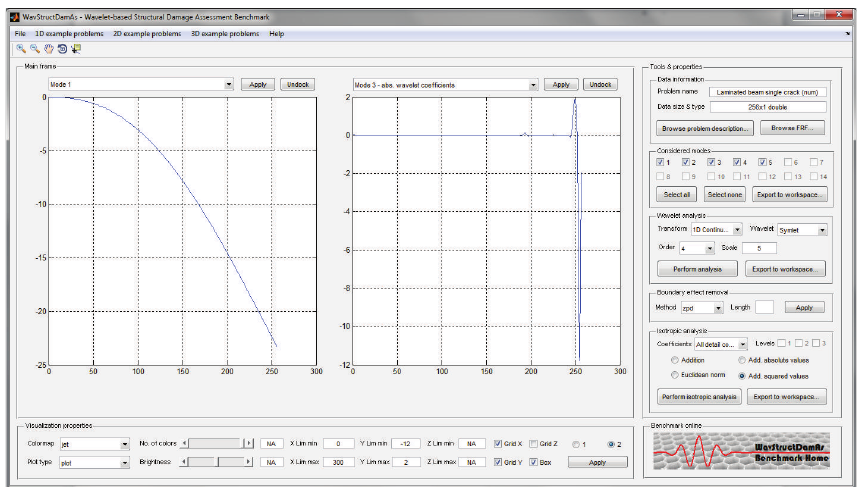
Figure 8: A benchmark window with results of laminated composite beam with a single crack example problem obtained using CWT-based approach.